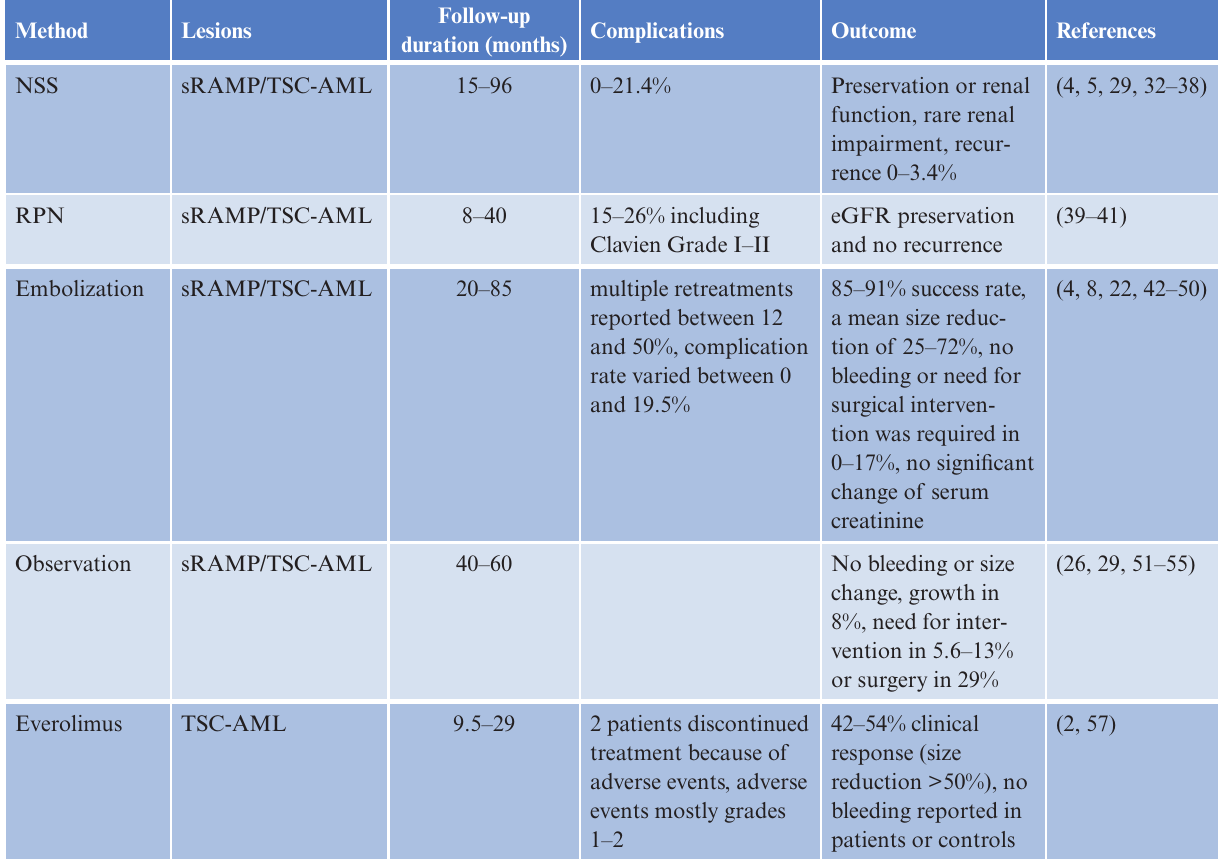
Table 1. Summary of selected series which included prophylactic management against the risk of